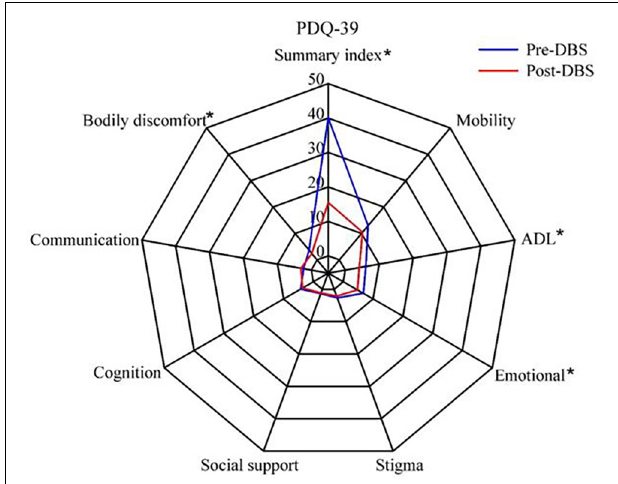
FIGURE 1 | Quality of life in patients with Parkinson’s disease before and after subthalamic stimulation. * P < 0.05.